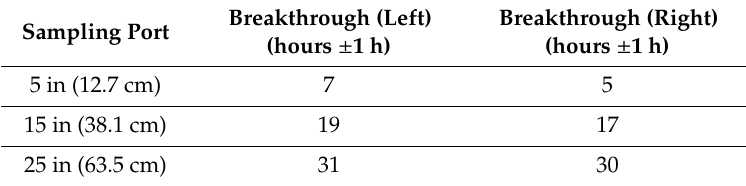
Table 2. Breakthrough times for E . coli